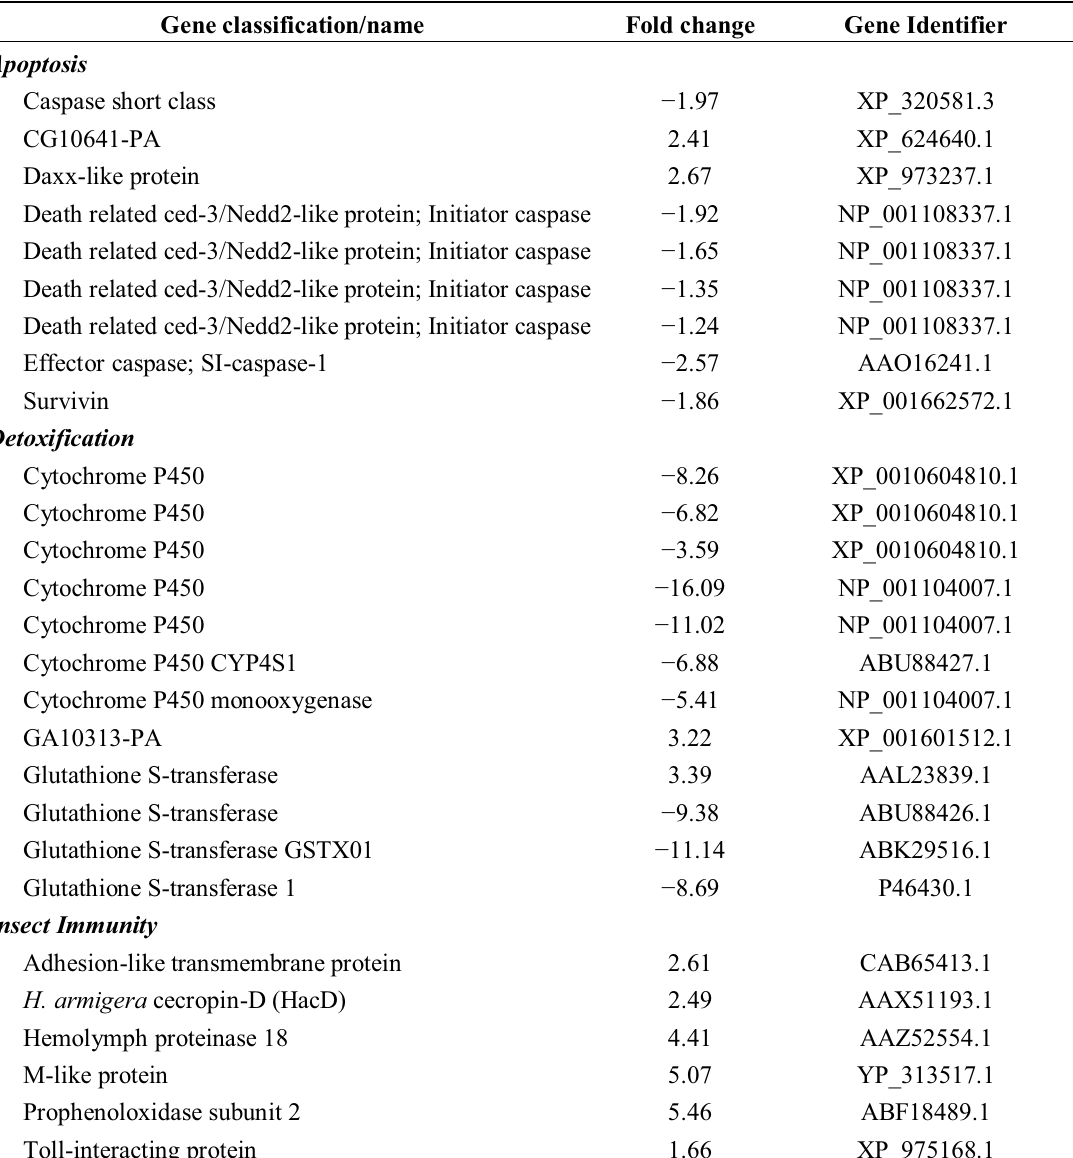
Table 2. Identified genes from the gut epithelium infected with HzSNPV pertaining to apoptosis, detoxification, and immunity with fold change and NCBI reference sequence indicated. The data listed represents the significant (Benjamini-Hochberg corrected t -test, p < 0.05) fold change in gene